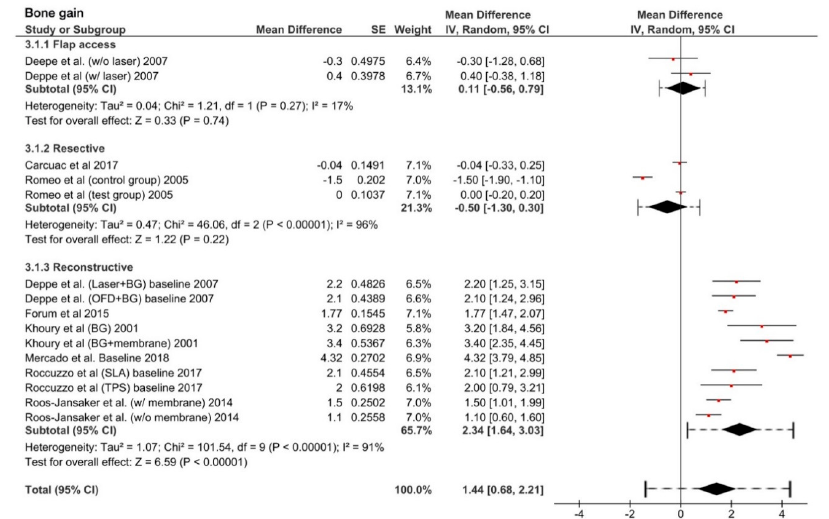
Figure 2. Radiographic bone level changes after treatment of peri-implantitis following flap access, resective or reconstructive approaches. Mean bone gain of each study is reported by a red dot. The 95% confidence interval of each study is indicated with a horizontal line intersecting the mean bone gain. The estimate average and confidence interval of all the individual studies are reported with black diamonds. Prediction intervals are reported as dotted lines intersecting the diamonds. A diamond on the right of the line of null effect indicates bone gain and a diamond on the left of the line of null effect indicates bone loss. Abbreviations. BG: bone grafting, CM: collagen membrane, OFD: open flap debridement, SLA: sandblasted acid-etched surface, TPS: titanium plasma-sprayed surface. Appl. Sci. 2019 , 9 , x FOR PEER REVIEW